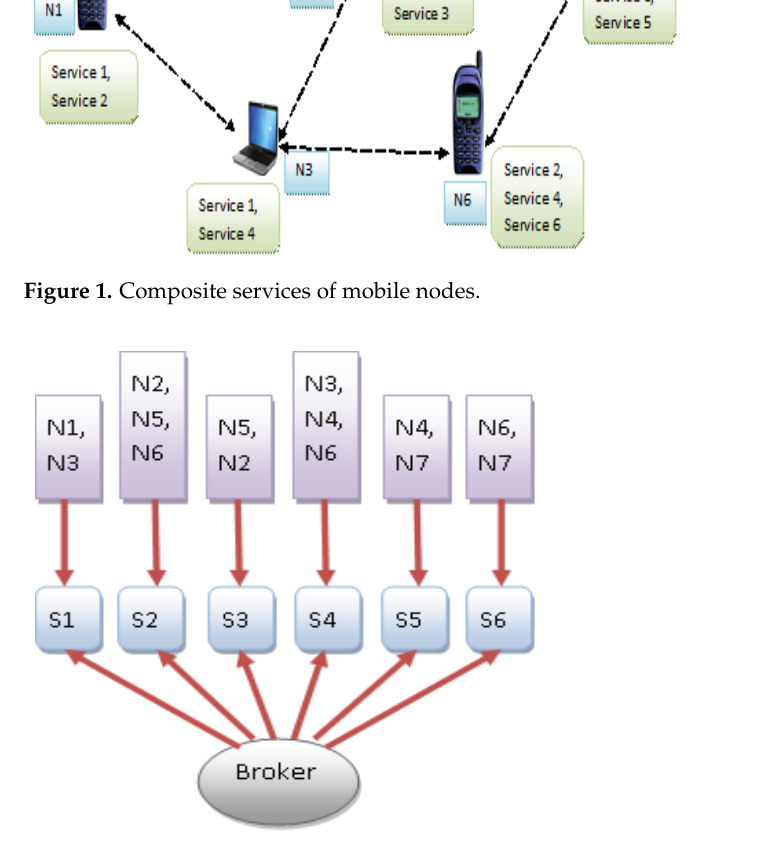
Figure 2. Selection of broker based on its services.